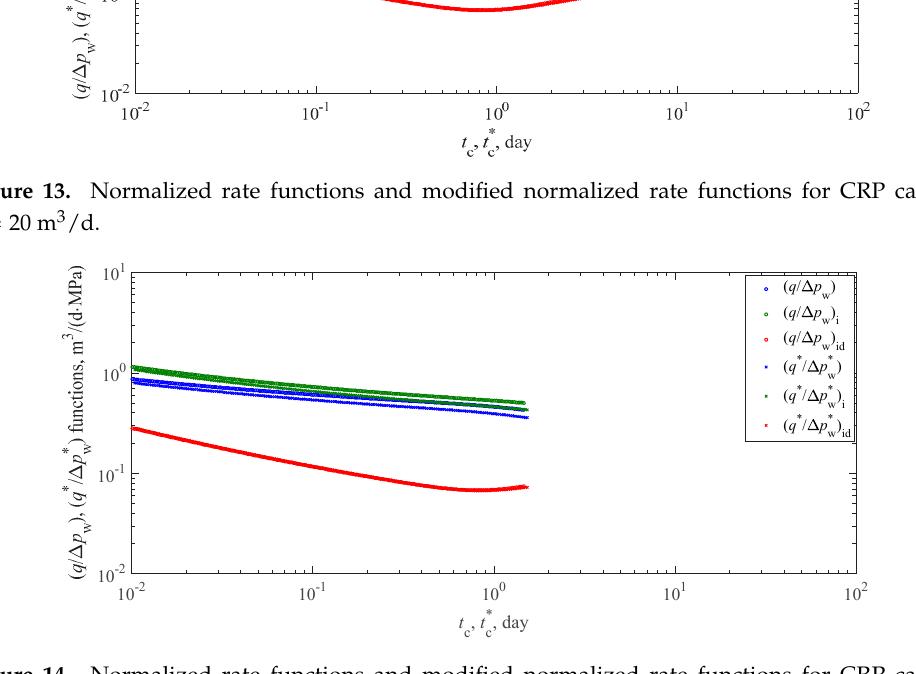
Figure 14. Normalized rate functions and modified normalized rate functions for CRP case of q = 30 m 3